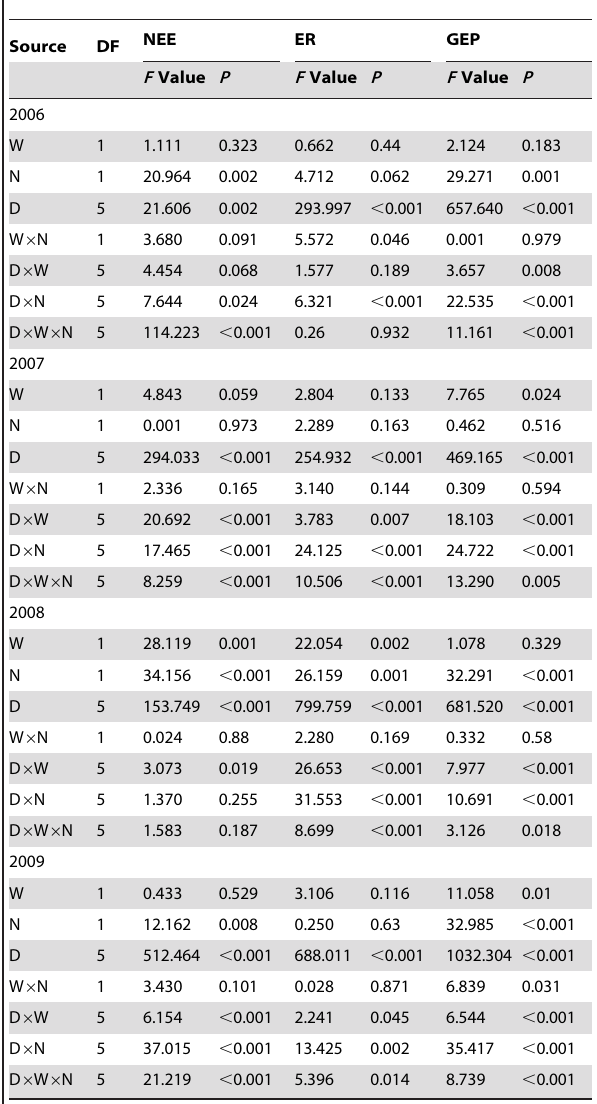
Table 2. DF, F values and P values from repeated measures ANOVA on the effects of warming (W), nitrogen (N), and measuring date (D), and their interactions on net ecosystem CO 2 exchange (NEE), ecosystem respiration (ER) and gross ecosystem productivity (GEP) for 2006, 2007, 2008 and